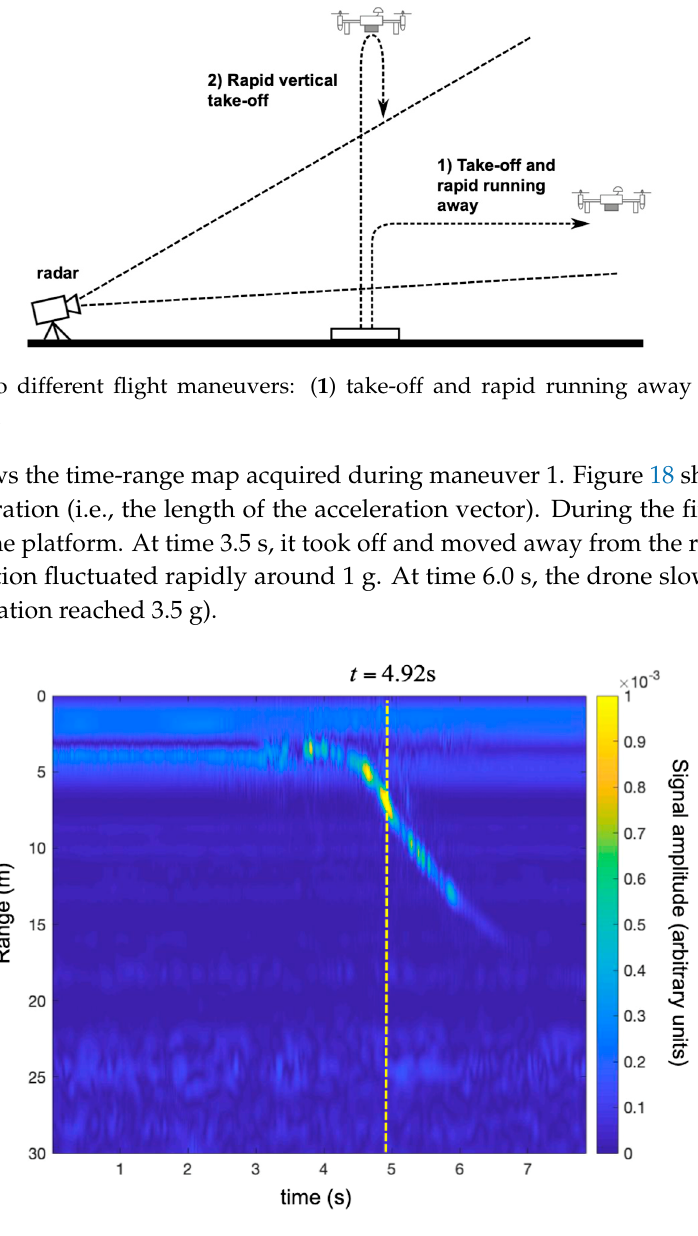
Figure 17. Detection of a small UAV using an SFCW radar. Time-range map without the Doppler correction during maneuver 1 (i.e., take-off and rapid running away).